Question: What kind of plot is shown here?
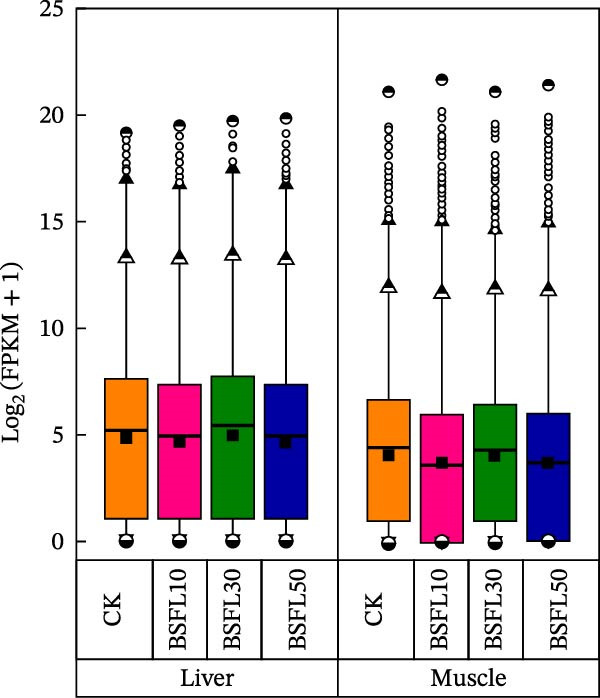
Answer: box